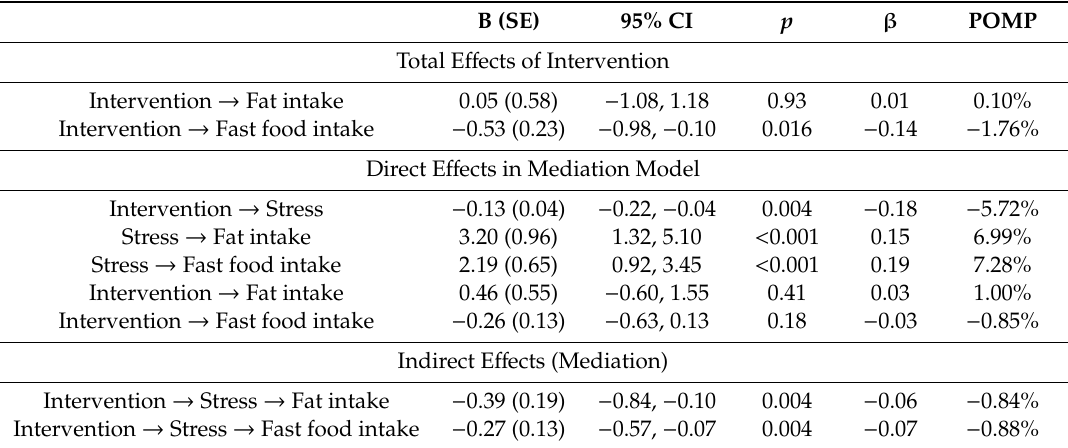
Table 1. Mediation model testing on 338 low-income overweight or obese mothers of young children (212 intervention, 126